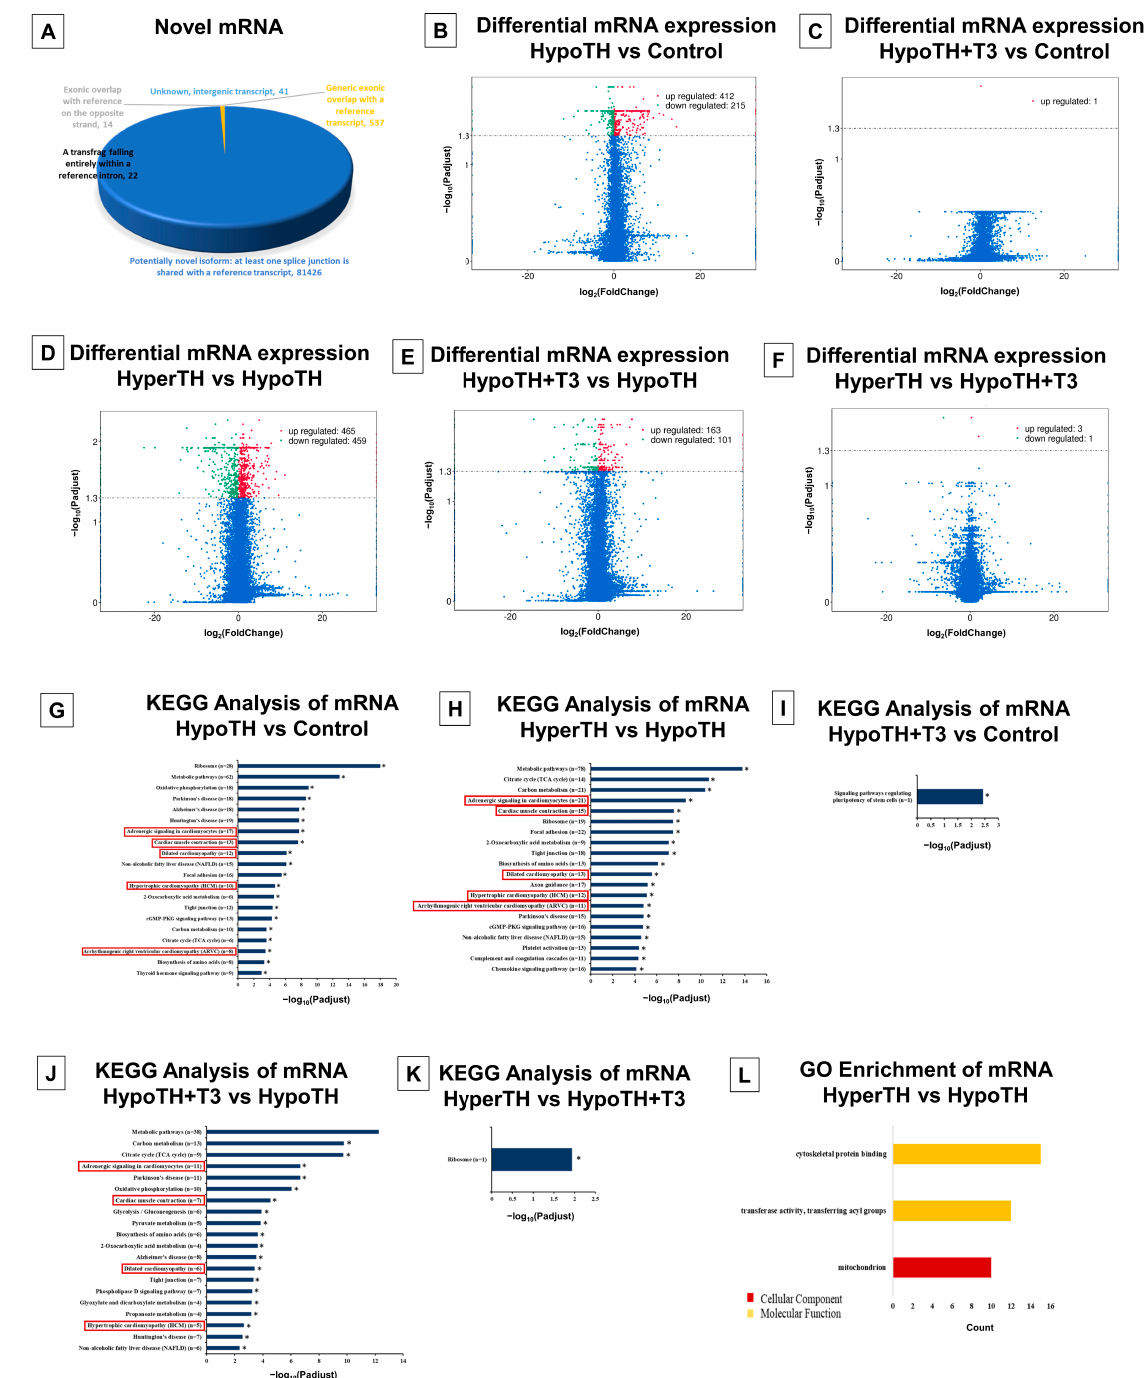
Figure 6. Novel and significant mRNA alterations and enrichments in TH dysfunction and restoration: ( A ) Novel mRNAs and different subtypes; ( B – F ) Significant differentially expressed mRNAs in ( B ) Hy- poTH vs. Control ( C ) HypoTH + T3 vs. Control ( D ) HyperTH vs. HypoTH ( E ) HypoTH + T3 vs. HypoTH ( F ) HyperTH vs. HypoTH + T3 groups; ( G – K ) KEGG enrichment analysis of pathways significantly altered mRNA targets in ( G ) HypoTH vs. Control ( H ) HyperTH vs. HypoTH ( I ) HypoTH + T3 vs. Control ( J ) HypoTH + T3 vs. HypoTH ( K ) HyperTH vs. HypoTH + T3 groups; ( L ) GO enrichment analysis of significantly altered mRNAs. Cardiac disease-associated pathways are highlighted in red boxes. Statistically significant KEGG hits (top 20 for ( G , H , J ) are also marked with asterisks. Only GO hits with p -adj(corr) < 0.05 were included in the